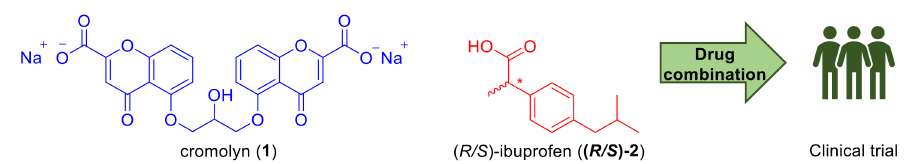
Figure 1. Cromolyn ( 1 )( R/S )-ibuprofen ( ( R/S )-2 ) drug combination investigated in Alzheimer’s disease (AD) clinical